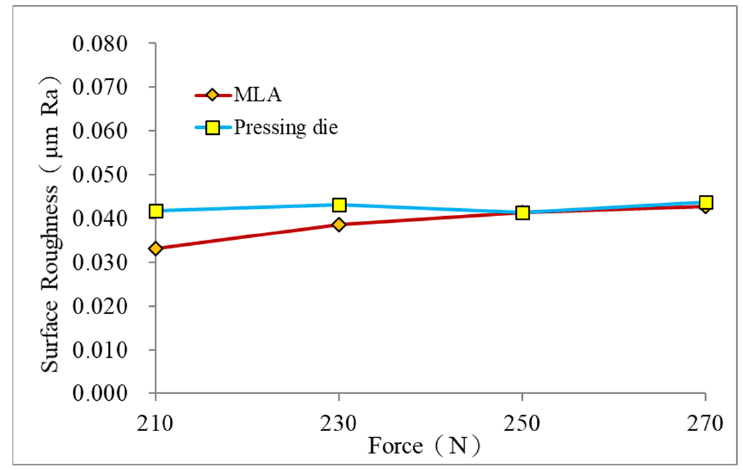
Figure 8. Effects of pressing force on surface roughness between pressing die and MLA.